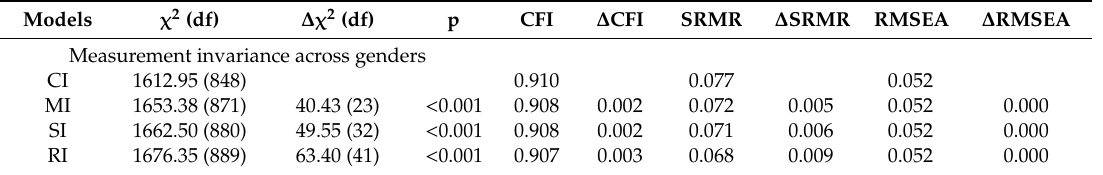
Table 4. Goodness-of-fit indexes of measurement invariance across